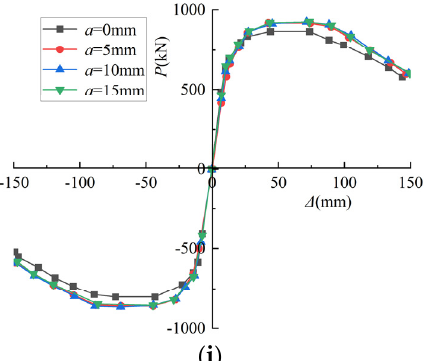
Figure 18. P- Δ skeleton curve: ( a ) Heating time; ( b ) Axial compression ratio; ( c ) Slenderness ratio; ( d ) Profiled steel ratio; ( e ) Steel tube ratio; ( f ) Concrete cubic compressive strength; ( g ) Yield strength of steel tube; ( h ) Yield strength of profiled steel; ( i ) Protective layer thickness.